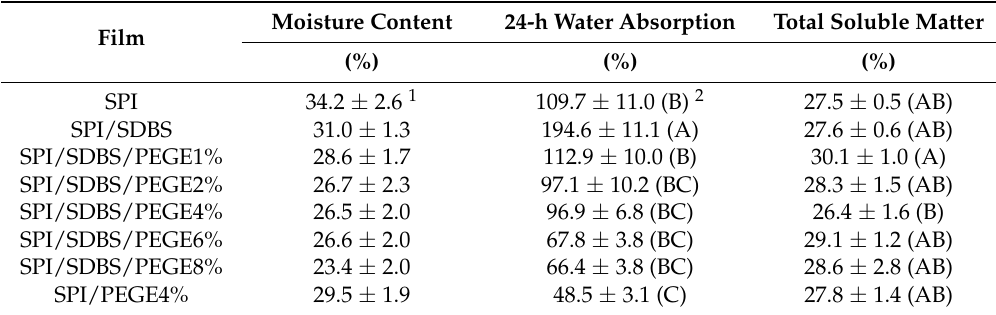
Table 5. Moisture content after conditioning, water absorption and total soluble matter after 24 h submersion of the SPI-based